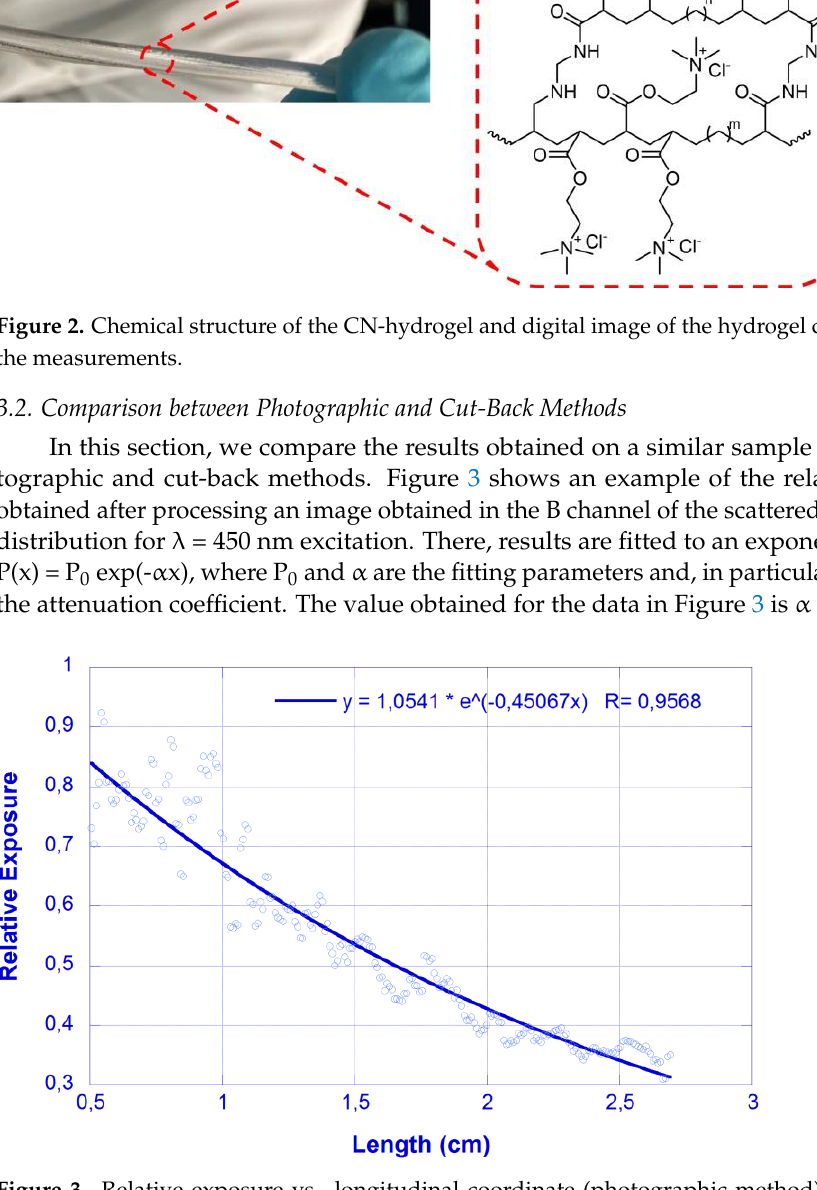
Figure 2. Chemical structure of the CN-hydrogel and digital image of the hydrogel cylinder used